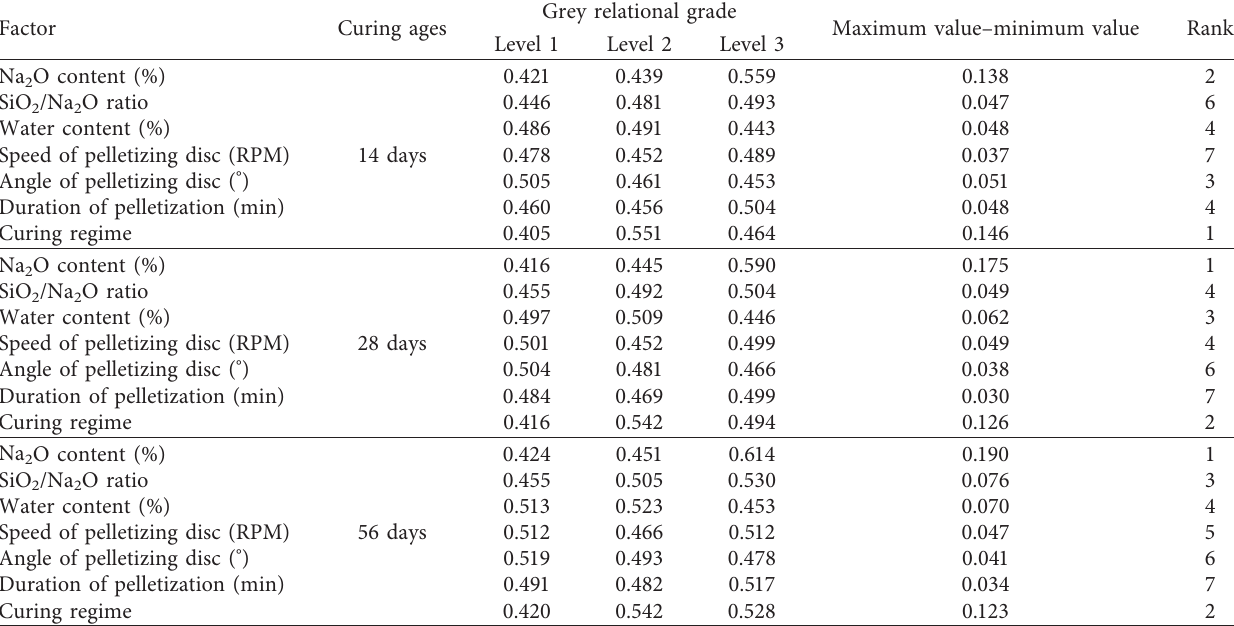
Table 8: Grey relational grade with respect to combined factors at various